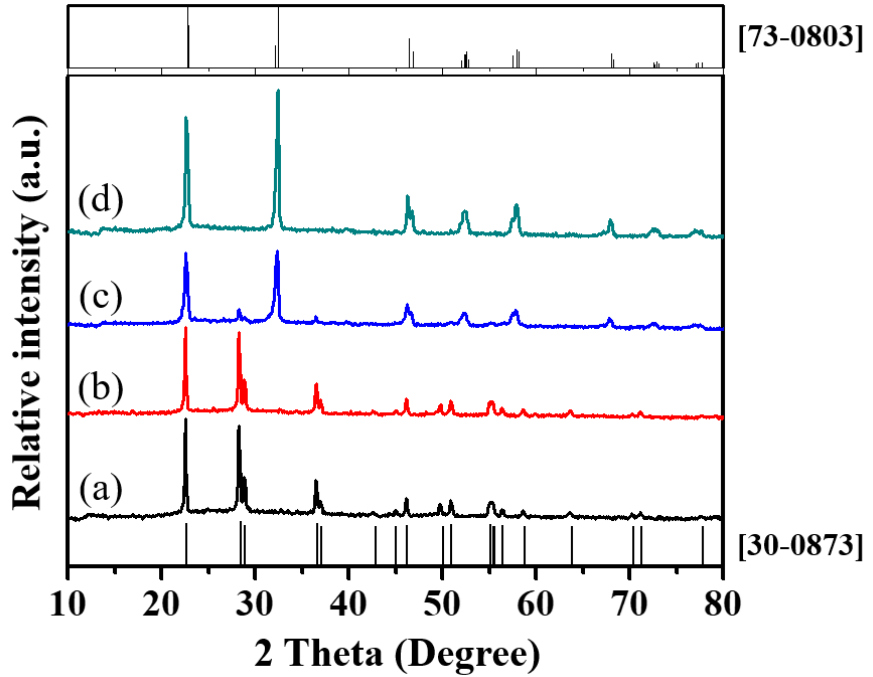
Figure 1. XRD patterns of KNN particles synthesized in glycothermal conditions at various reaction temperatures for 12 h: ( a ) 80 °C, ( b ) 120 °C, ( c ) 160 °C, and ( d ) 200 °C. JCPDS database for Nb 2 O 5 (JCPDS card 30-0873) and NaNbO 3 (JCPDS card 73-0803) are also included in the figure.